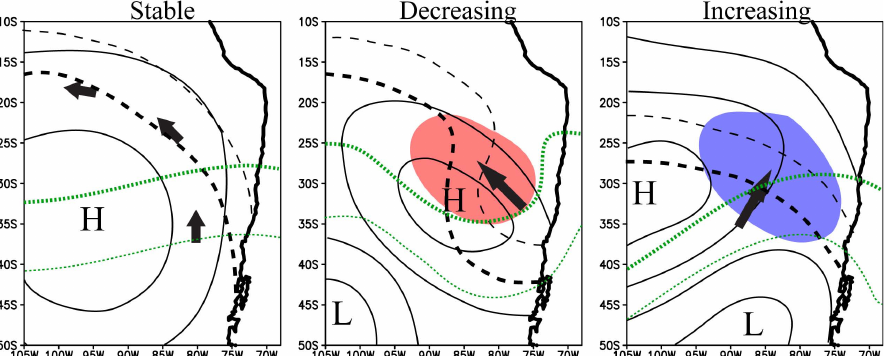
Fig. 14. Conceptual model of synoptic conditions during periods of stable, decreasing, and increasing MBL height. Solid contours indicate isobars with high and low pressure labeled. Black, dashed contours indicate isopleths of MBL depth for lower (thin) and higher (bold) height. Green, dotted contours indicate isopleths of 500-hPa height for lower (thin) and higher (bold) height. Vectors indicate low-level wind speed and direction. Decreasing (increasing) MBL heights indicated by red (blue)